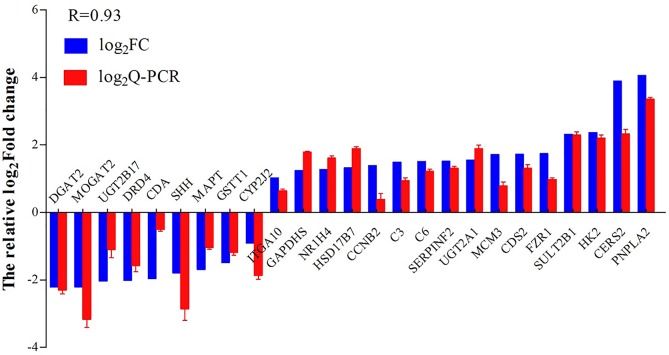
Validation of Q-PCR.Comparison of the relative log2 (fold changes) between RNA-Seq and qPCR after salinity acclimation compared to the control, as normalized with the EF1A gene.